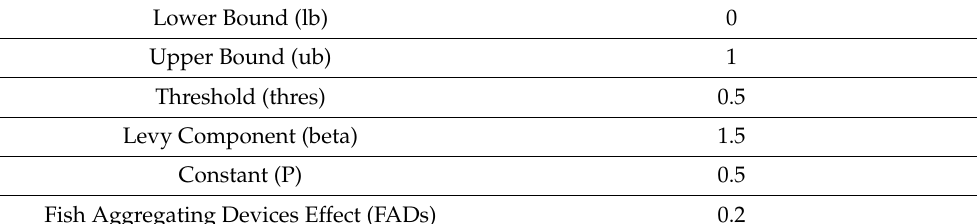
Table 2. Pre-trained parameters of MPA.